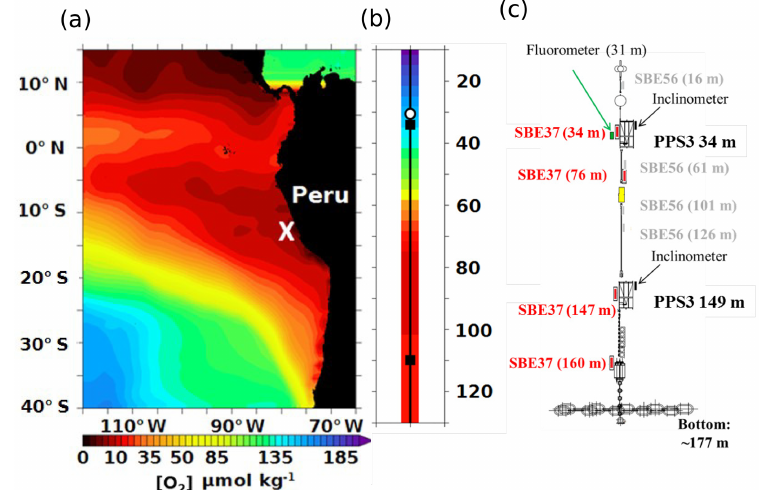
Figure 1. Study area, OMZ O 2 conditions and design of the mooring. (a) Map of the eastern South Pacific oxygen minimum zone (in red with [O 2 ] minimal < 20µmolkg − 1 from WOA2013 climatology). This map includes the location of the AMOP mooring (white cross, 77.40 ◦ W – 12.02 ◦ S) off Peru. (b) Vertical distribution of the oxygen concentration at the mooring location (from WOA2013 climatology with the two sediment trap locations in the black square). (c) Design of the fixed mooring line including two sediment traps, PPS3 with two inclinometers at 34m near the oxycline and at 149m in the OMZ core, as well as five sensors of pressure, temperature, salinity and oxygen (SBE37-ODO63) at 34, 76, 147 and 160m, a fluorometer at 31m, and complementary temperature sensors (SBE56). Sensor depths are indicated to ± 1m, estimated from sensor pressure and inclinometer data (see Sect.